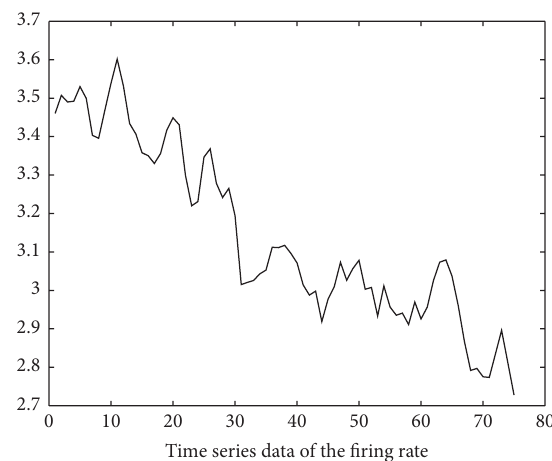
Figure 13: Firing rate series of